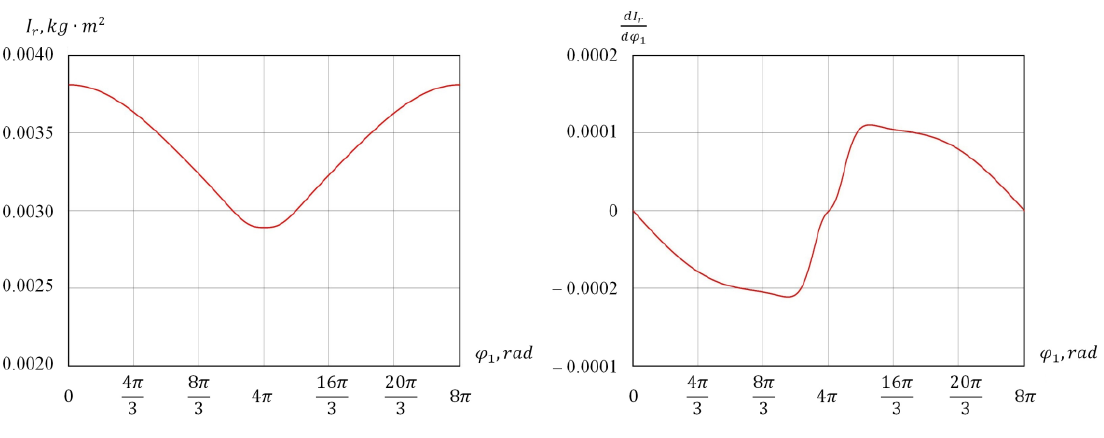
Figure 7. Graphs of functions I r ( ϕ 1 ) , dI r